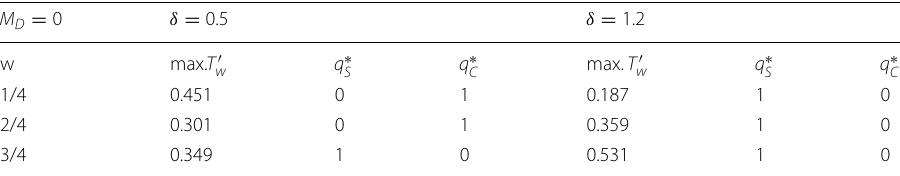
Table 9 The values of q ∗ queue at S is unstable, α = 0.7, M U = 200, M D = 0, and M S = 2000 M D =